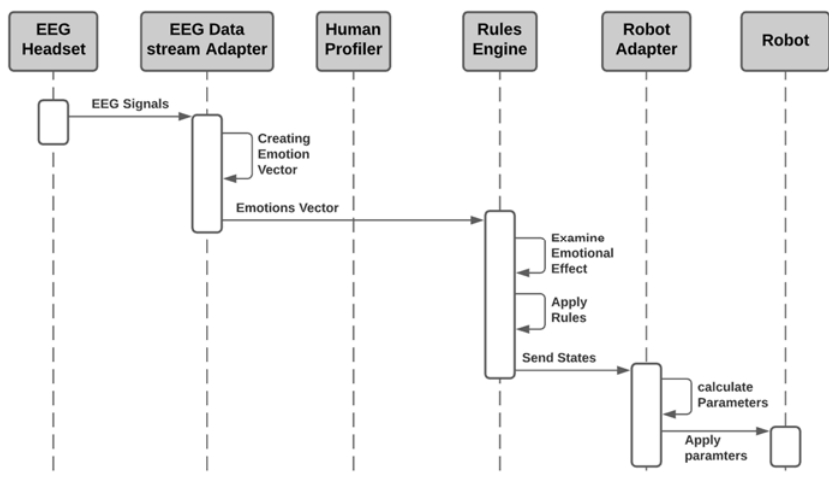
Figure 4. Sequence diagram of the operational mode.